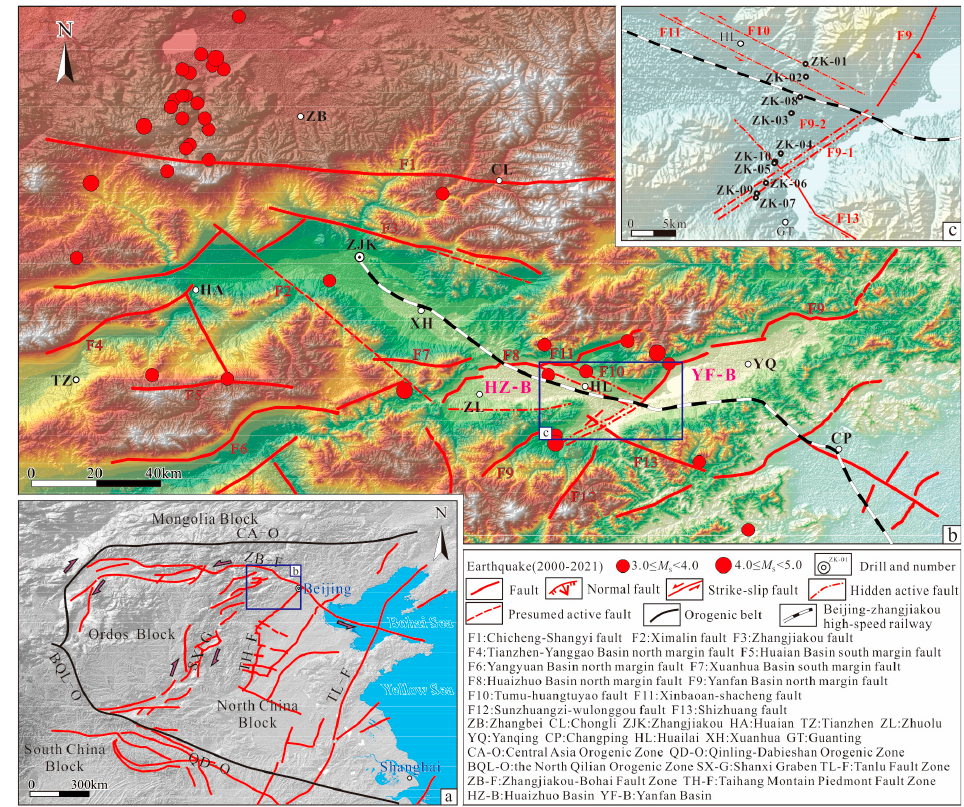
Figure 1. Tectonic geology diagram of Zhangjiakou area.